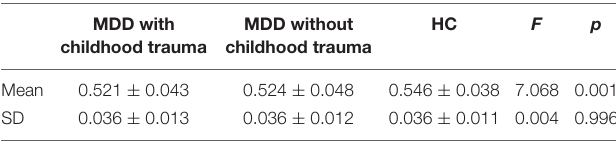
TABLE 4 | Comparison of volume wise concordance among the MDD with childhood trauma, MDD without childhood trauma, and HC groups. MDD with MDD without childhood trauma childhood trauma